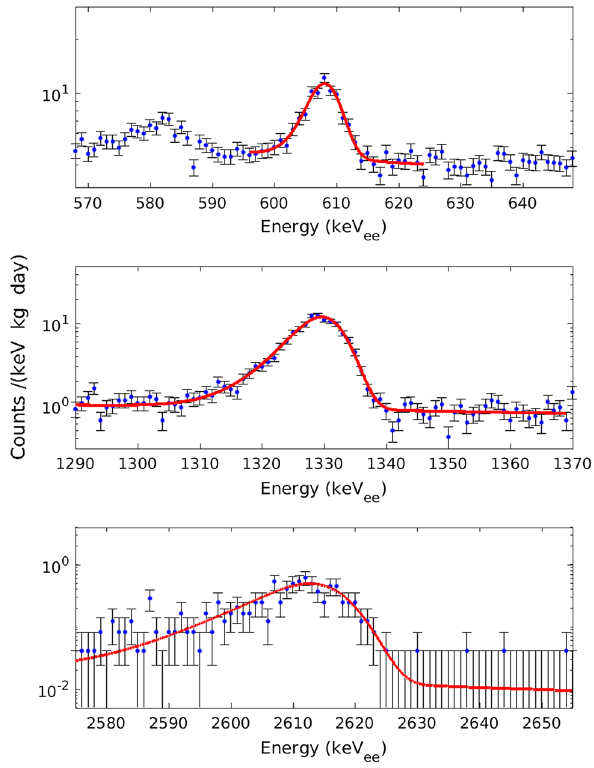
Fig. 4 γ peaks from a background spectrum of one of the 48depl Ca 100 MoO 214 Bi. Middle: 4 detectors. Top: 609 keV from 1332 keV from 60 Co. Bottom: 2615 keV from 208 Tl. Solid lines show the best fit of the gamma peaks by exponentially modified Gaussian (see text) with an exponential function to describe the continuous back- ground. The skewness increases with the